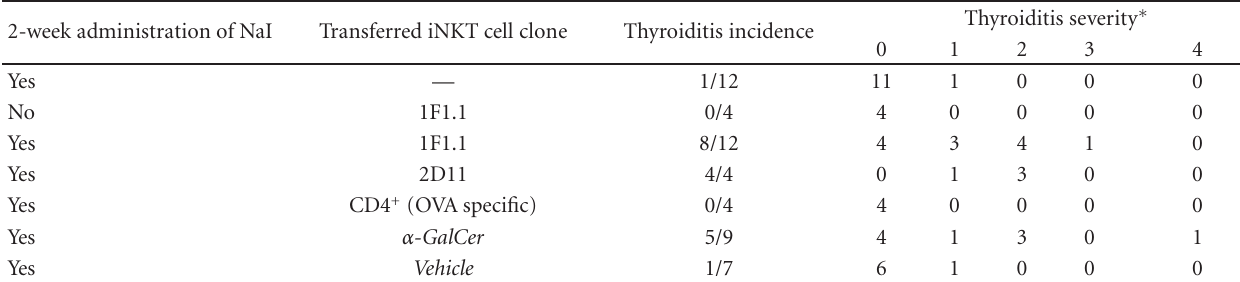
Table 1: Incidence and severity of thyroiditis after transfer of iNKT cell clones to NOD · H2 h4 mice. 2-week administration of NaI Transferred iNKT cell clone Thyroiditis